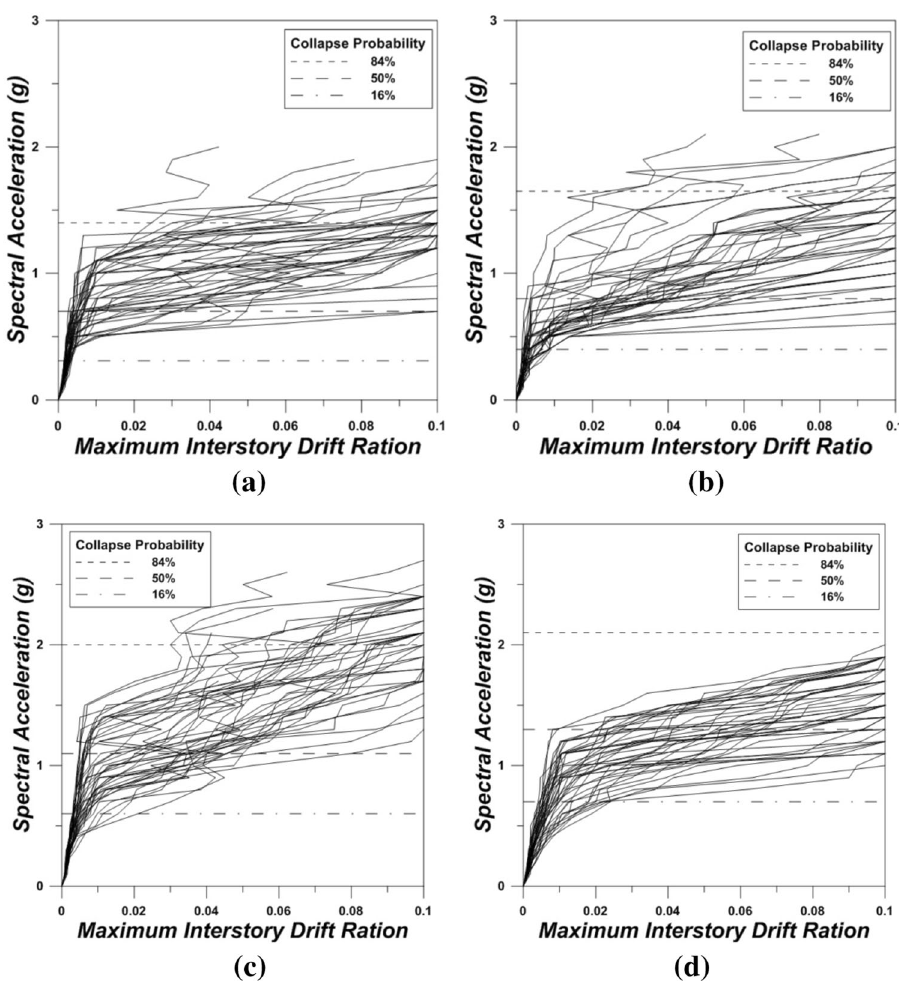
Fig. 22 Incremental dynamic analysis curves of the analysis model structures. a SD ð d S CT ¼ 0 : 7 Þ , b CD ð d S CT ¼ 0 : 8 Þ , c